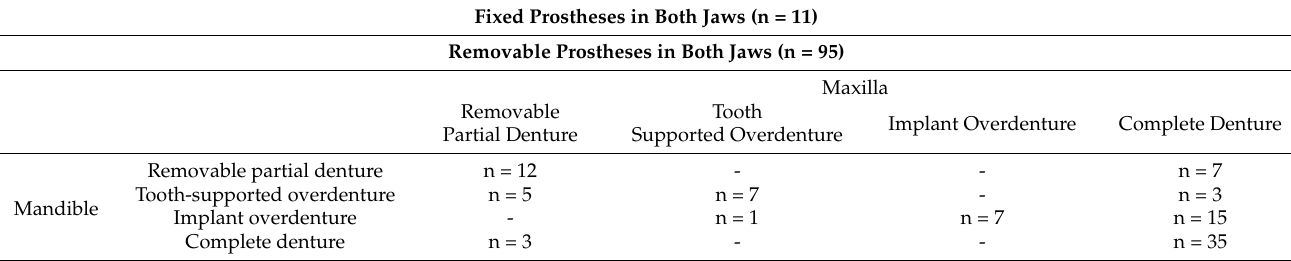
Table 1. Study sample’s prosthetic